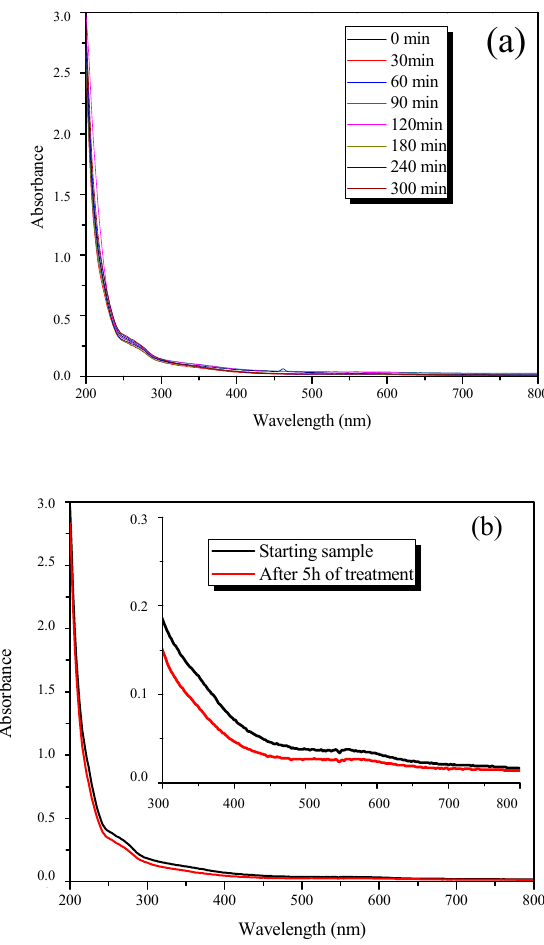
Figure 14. UV-Vis spectra obtained during the photocatalytic treatment of colored wastewater coming from Colombian handicrafts factories by using P25 as a photocatalyst ( a ) and ( b ) Initial spectra and final results obtained after 5 h of photocatalytic treatment.